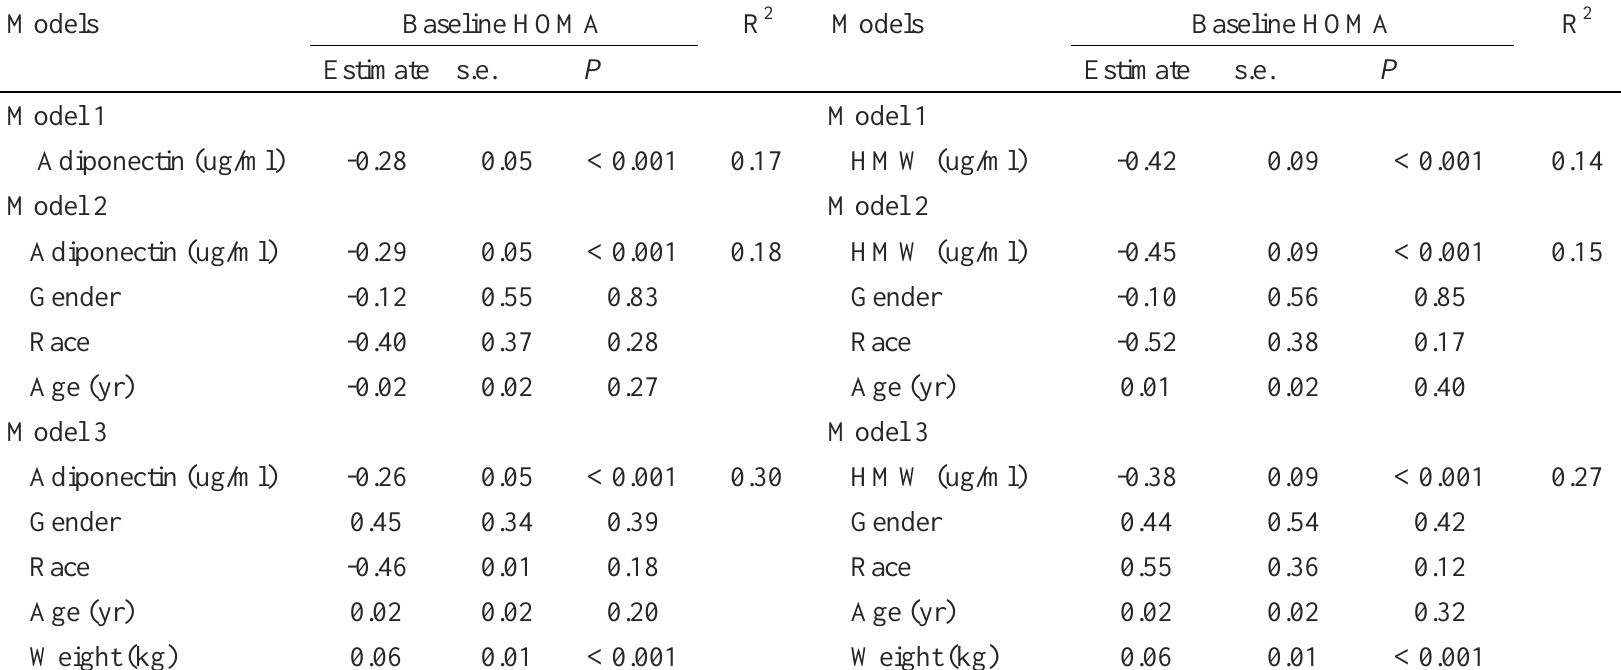
Table 2: Multiple regression models of total and HMW adiponectin levels on baseline HOMA measure (N =